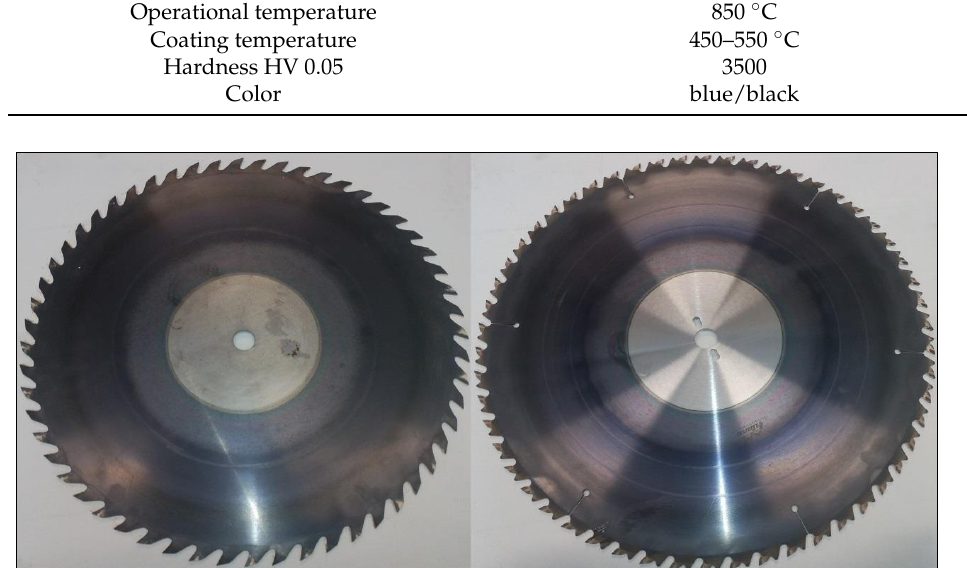
Figure 1. Saw blades with MAXIMIZER coating (HSS_M, SK_M).